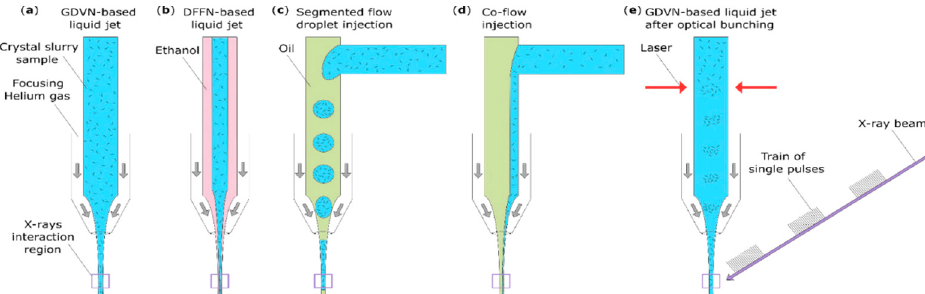
Figure 1. Schematic representations of standard ( a , b ) and innovative ( c – e ) injection delivery methods that are compatible with megahertz operation at the EuXFEL: ( a ) a GDVN-based liquid jet; ( b ) a DFFN-based liquid jet [38]; ( c ) a co-flow injection [44]; ( d ) a segmented flow droplet injection [45]; ( e ) a GDVN-based liquid jet with optical bunching [46].